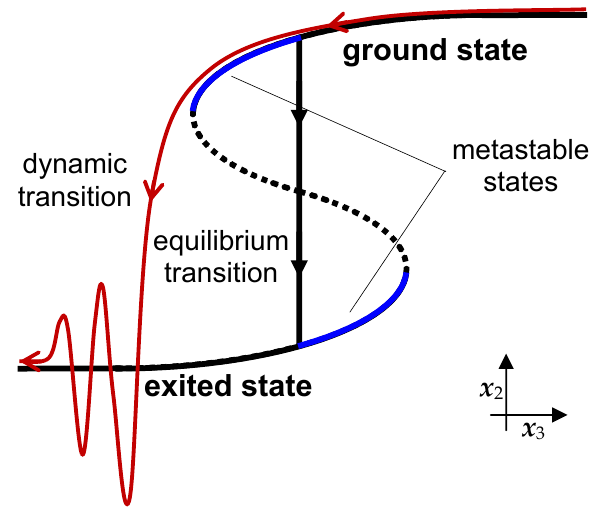
Fig. 10. The diagram of different transitions in a two-level system. The coexistence manifold and corresponding transitions from the ground to the exited state are shown in x 1 − x 3 plane. Equilibrium transitions correspond to the straight line connecting two branches associated with different states. The metastable states correspond to the blue segments of the manifold. An example of a typical dynamic transition which deviates from the equilibrium manifold is shown in